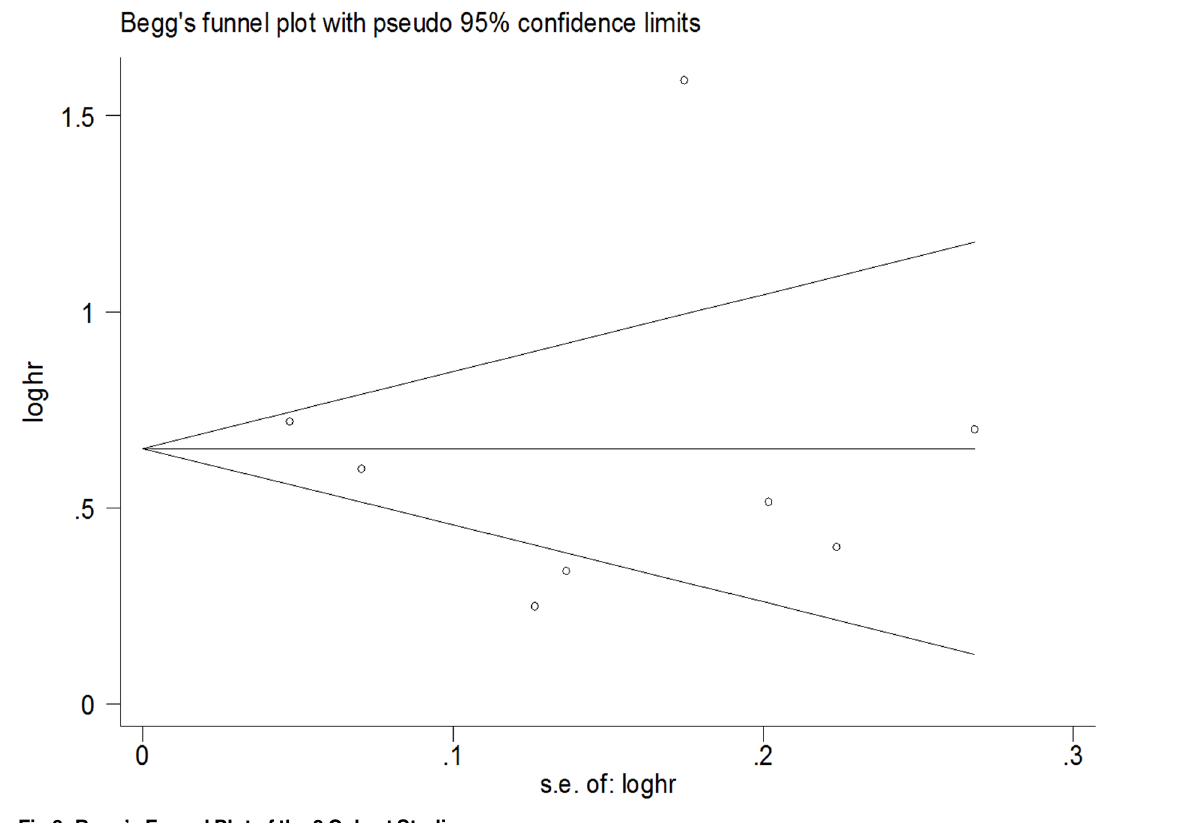
Fig 6. Begg ’ s Funnel Plot of the 8 Cohort